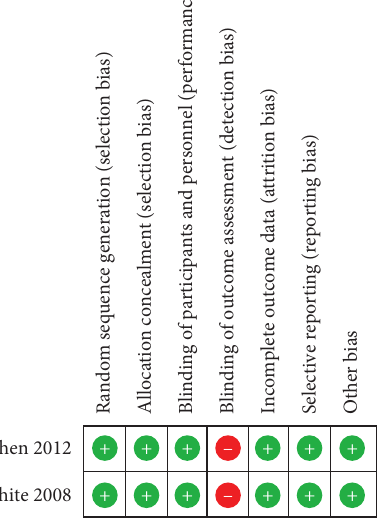
Figure 3: Summary of risk of